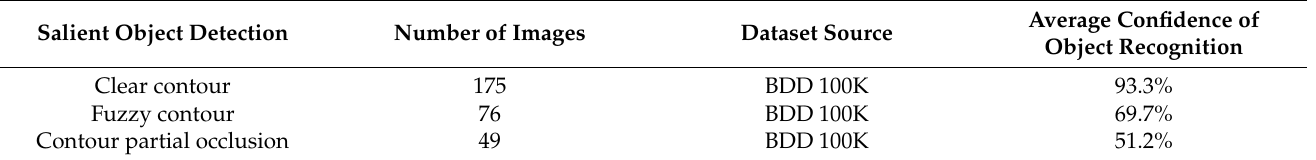
Table 6. The relationship between the imaging of the salient object contours and the recognizability of the salient objects.